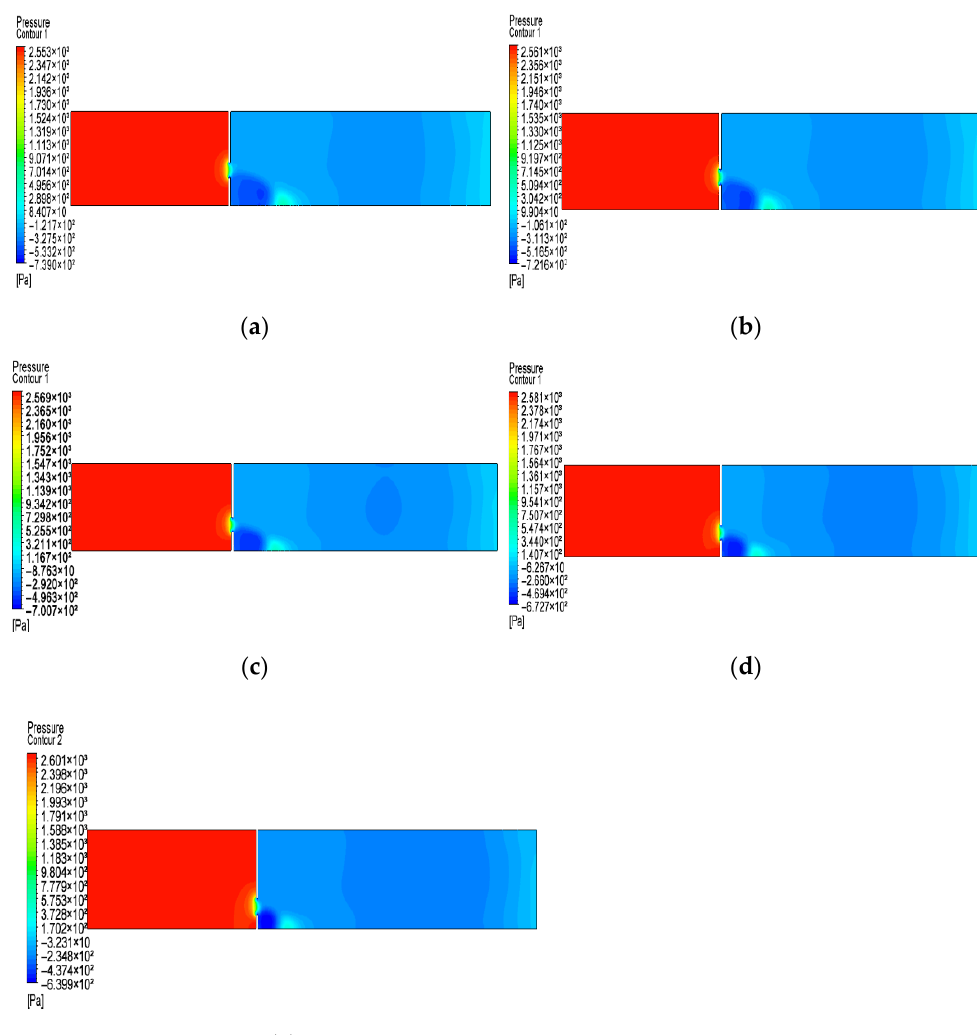
Figure 5. Pressure cloud diagram of different personnel door positions at the same air speed. ( a ) 200 mm; ( b ) 400 mm; ( c ) 600 mm; ( d ) 800 mm; ( e ) 1000 mm.